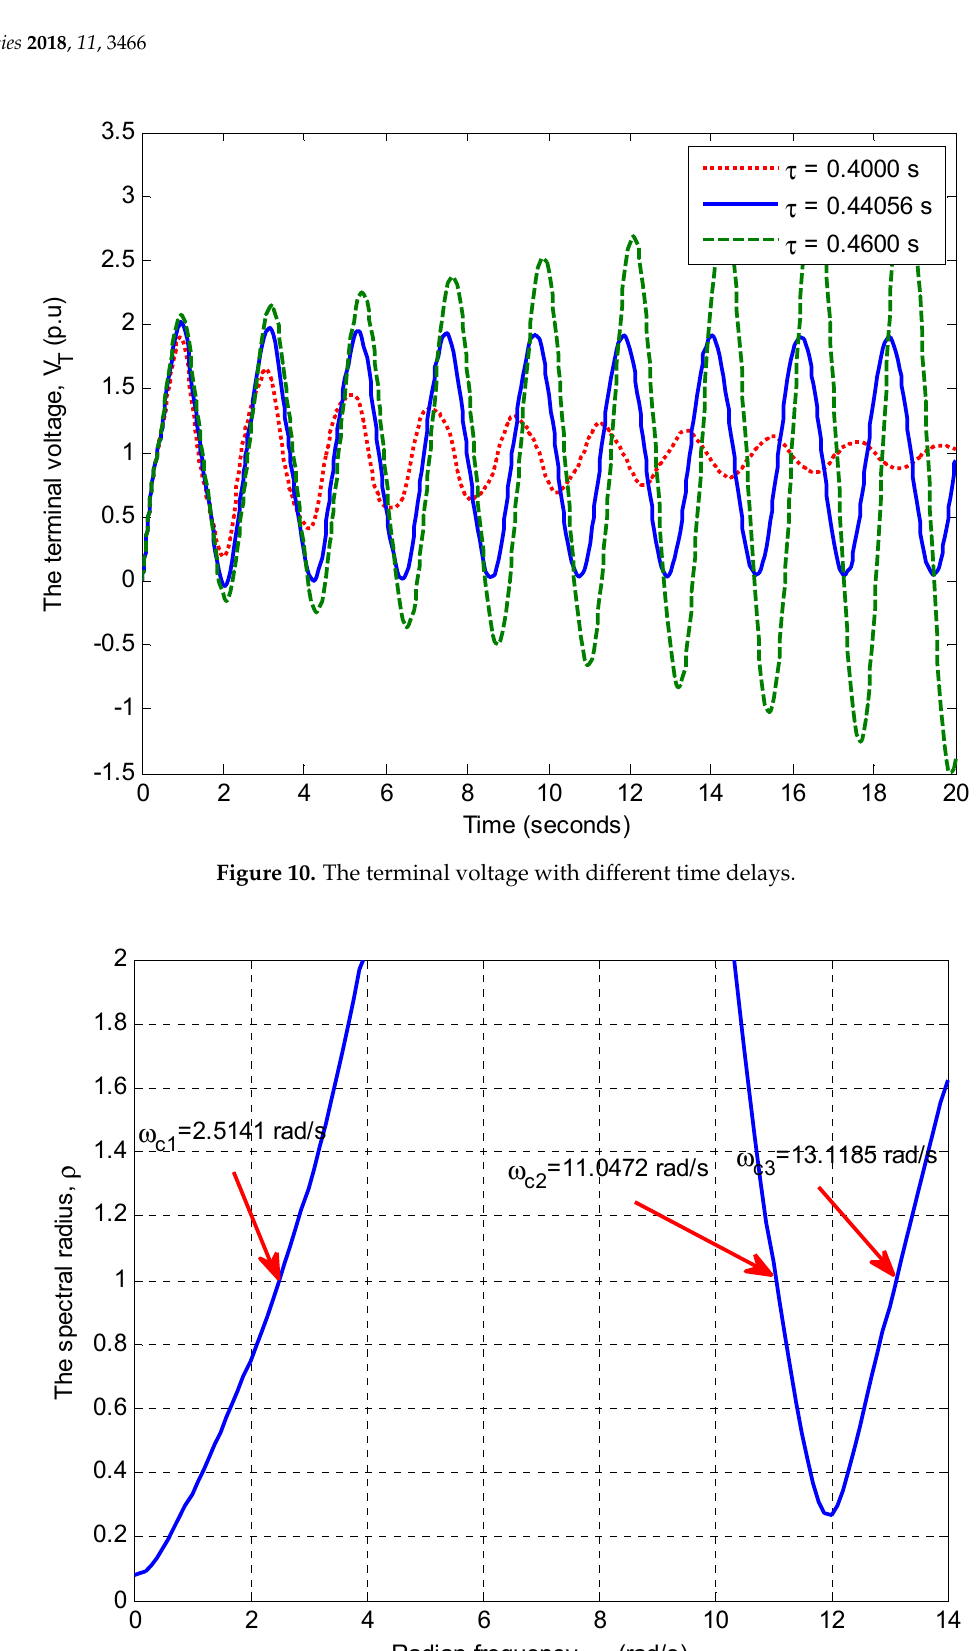
Figure 9. The terminal voltage with different time delays.